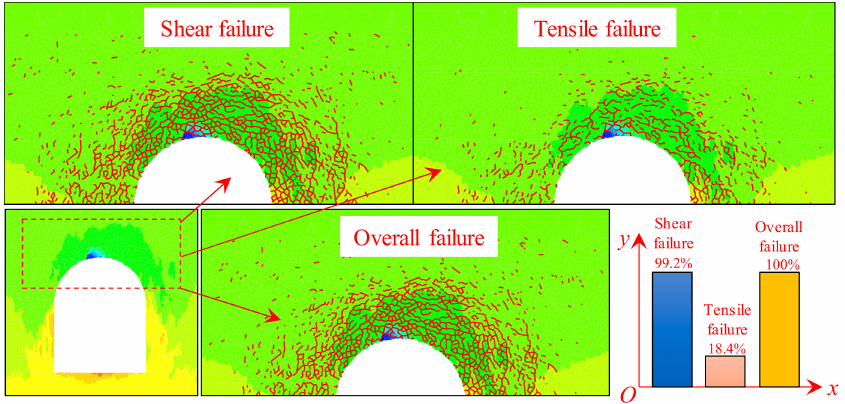
Figure 13. Mechanical mechanism of the crack generation in the chamber